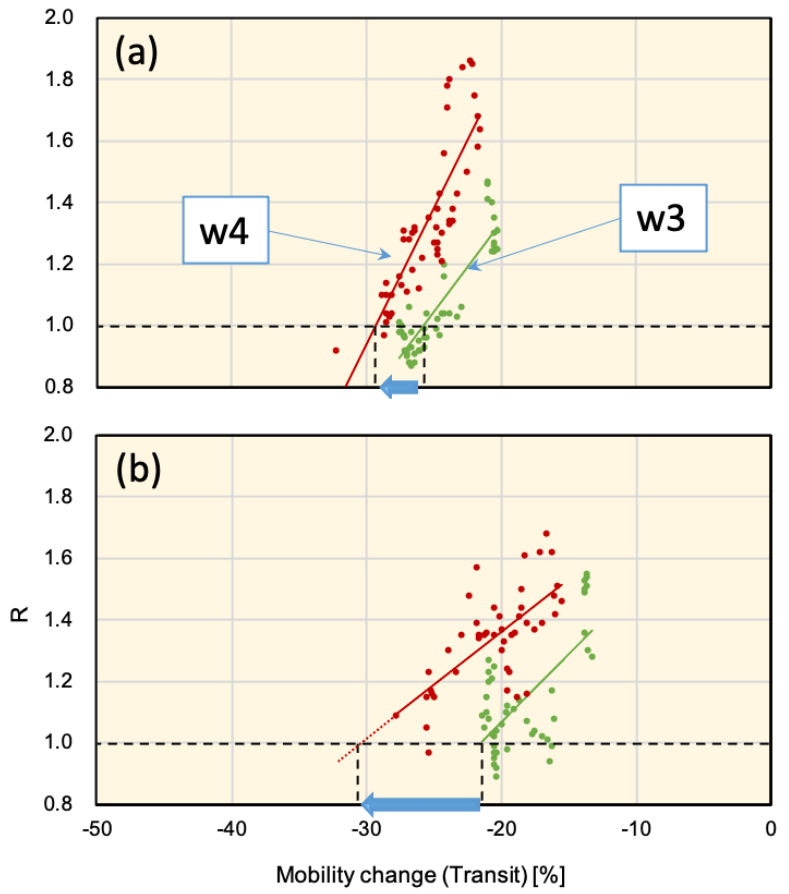
Figure 9. Plots of effective reproduction number ( R ) and corresponding mobility change (Transit) in ( a ) Osaka and ( b ) Hyogo for time slots w 3 and w 4 defined in Figure 8a. Considering all other factors unchanged, to reduce the upsurge (i.e., reach to R =1.0), mobility at transit spots is required to be reduced by 4 and 9 points in Osaka and Hyogo,